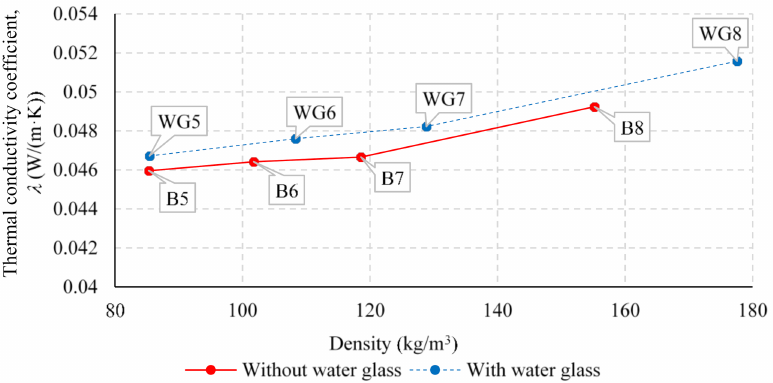
Figure 8. Relationship between thermal conductivity coefficient λ and density of the produced ther- mal insulation boards for specimens with a thickness of 50 mm with and without added water